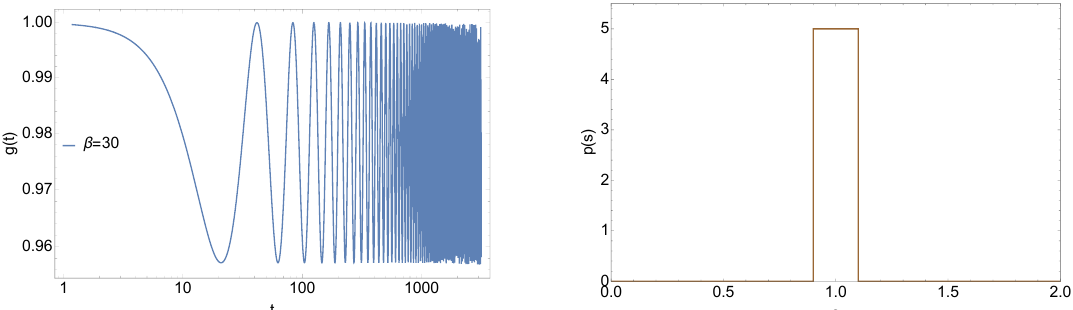
Figure 11. SFF (left) and level spacing distribution (right) for 3 d Rindler normal modes with only n sum (with ξ = 20 , n = 200 and J is fixed to one) at β = 30 . Other parameters R and a 0 cut are fixed to 2 and 1 . The bin size on the right is 0.1.